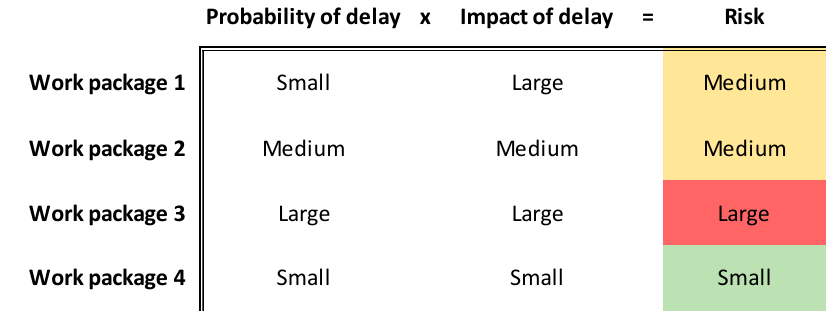
Figure 5. An example of a rough risk analysis of the significance of delays of wagons.